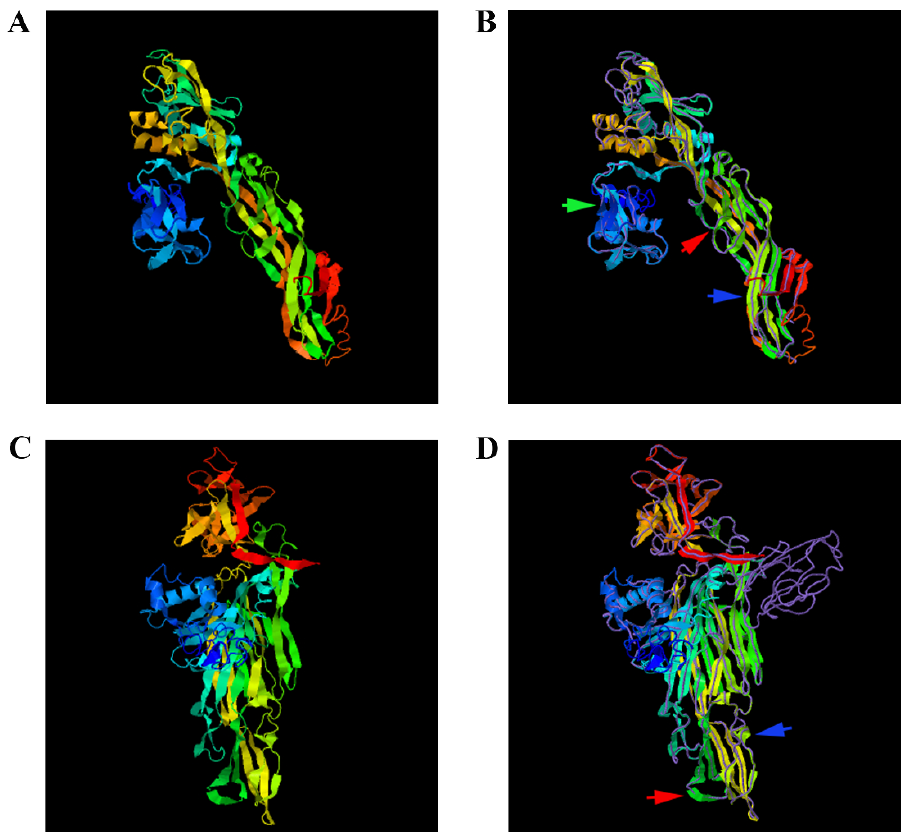
Figure 6. Protein structure prediction of AerA and HlyA of A . salmonicida . ( A ) shows the predicted A . salmonicida AerA protein structure model; ( B ) is the structural comparison of the aerolysin domain of A . salmonicida (color) and the closest known protein structural model (purple) in PDB library (PDB ID: 1z52A). Aerolysin protein is composed of two lobes: a small lobe (pointed out by the green arrow) and a large lobe (pointed out by the blue arrow). The proaerolysin TMD is pointed out by the red arrow. Domain 1 of the small lobe and domain 2 of the large lobe have high affinity for ankyrin. ( C ) shows the predicted A . salmonicida HlyA protein structure model; ( D ) is the structural comparison of the aerolysin domain of A . salmonicida (color) and the closest known protein structural model (purple) in PDB library (PDB ID: 1xezA). A . salmonicida hemolysin protein is composed of three different domains, and the hemolysin domain (pointed out by the red arrow) is the core of its structure and function. The rim domain loop (pointed out by the blue arrow) in the hemolysin domain is the key for the toxin to bind to erythrocyte membranes and lipids with phosphocholine.